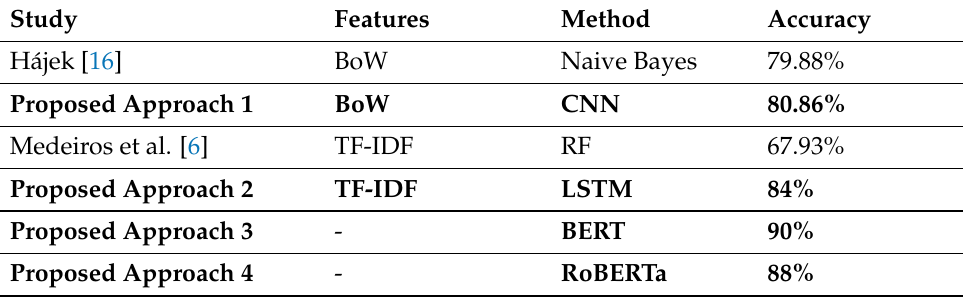
Table 18. Comparison with state-of-the-art